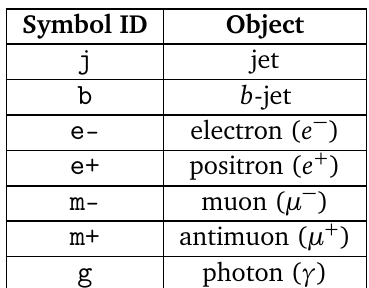
Table 1: Definition of symbols used for final-state objects. Only b -quark jets are tagged, no τ - or c -jets have been